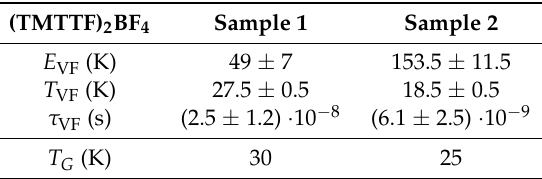
Table 2. Parameters obtained by fitting the temperature-dependent dielectric relaxation time τ 0 ( T ) of (TMTTF) 2 BF 4 with the Vogel-Fulcher-Tammann relation. E VF is the activation energy, T VF denotes the Vogel-Fulcher temperature, and τ VF the corresponding time scale. The glass temperature is given by T G .